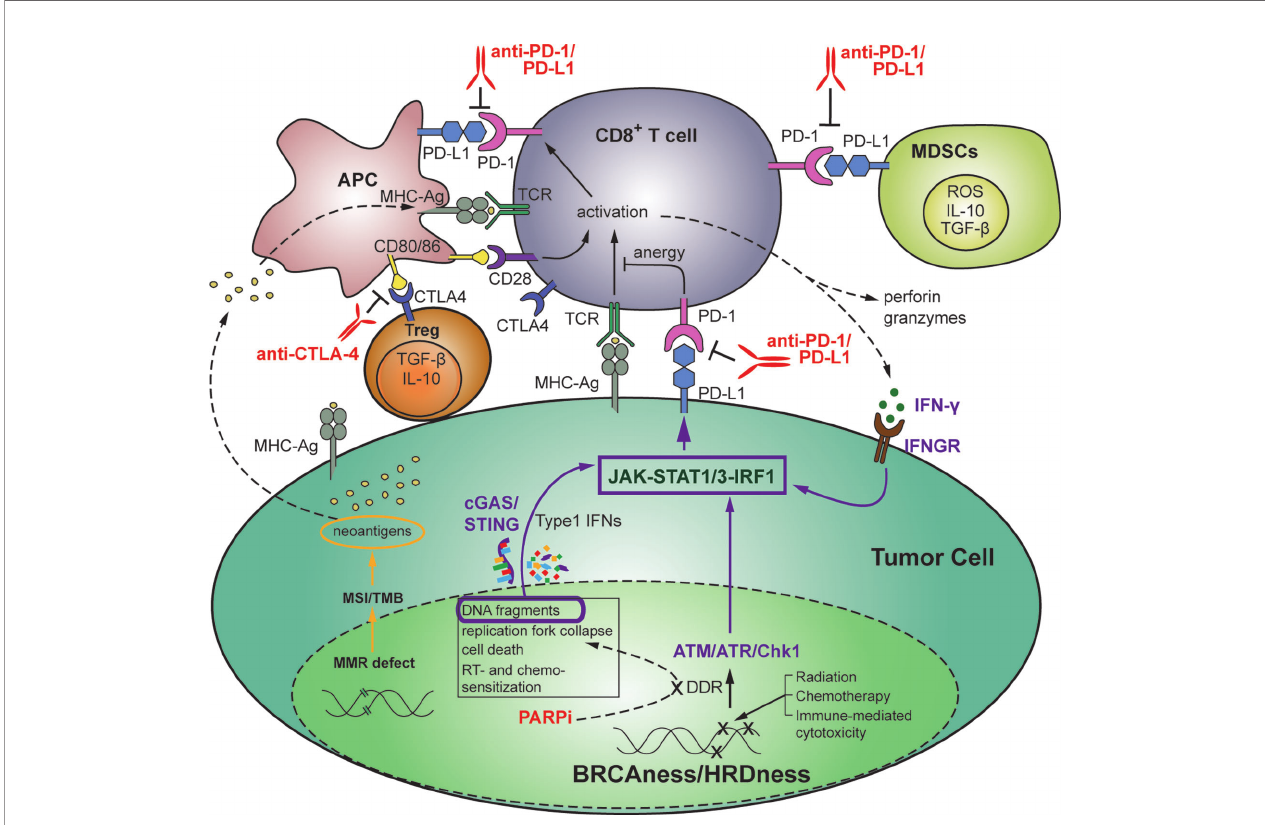
FIGURE 2 | Therapeutic strategies targeting the interplay between DDR and anti-tumor immunity in the setting of HR-de fi cient triple-negative breast cancer. DNA damage affects the balance between tumor progression and immune surveillance. Genomic stress induced by DNA-damaging treatments or by defects in DDR or MMR results in accumulation of chromosomal abnormalities, higher TMB, oncogene activation and tumorigenesis, as well as immune recognition, activation of immunostimulatory genes, and increased TILs including anti-tumor immune cells (CD8 + T cells, APCs, CD4 + T cells, and NK cells). Immunosuppressive immune cells such as CD4 + Tregs, MDSCs and M2 macrophages can also be increased. Targeting of SSB and DSB repair with inhibitors of DDR, including PARPi ’ s, in the setting of TNBC with BRCA or HR-related mutations (BRCAness/HRDness) can, in addition to inducing synthetic lethality, increase generation of cytosolic DNA fragments. This results in activation of the immunomodulatory cGAS/STING pathway that promotes anti-tumor immunity through activation of T and NK cells, neoantigen recognition, and increased PD-L1 expression via the JAK-STAT1/3-IRF1 pathway. Anti-tumor immunity can further contribute to tumor PD-L1 expression via IFN- g -dependent activation of IRF1. Tumor and immune cell expressed PD-L1 subsequently suppresses PD-1 + cytotoxic anti-tumor immune cells via inhibitory binding. Thus, DNA-damage induced anti-tumor immune response is often overwhelmed by coexisting immunosuppressive factors, and the balance in favor of anti- tumor immune rejection can be mediated by ICIs such as anti-PD-1/PD-L1 and anti-CTLA-4 mAbs. APC, antigen presenting cells; ICI, immune checkpoint inhibitor; mAb, monoclonal antibody; MDSC, myeloid-derived suppressor cells; MMR, mismatch repair; NK, natural killer; TIL, tumor-in fi ltrating lymphocyte; TMB, tumor mutational burden; Treg, T regulatory